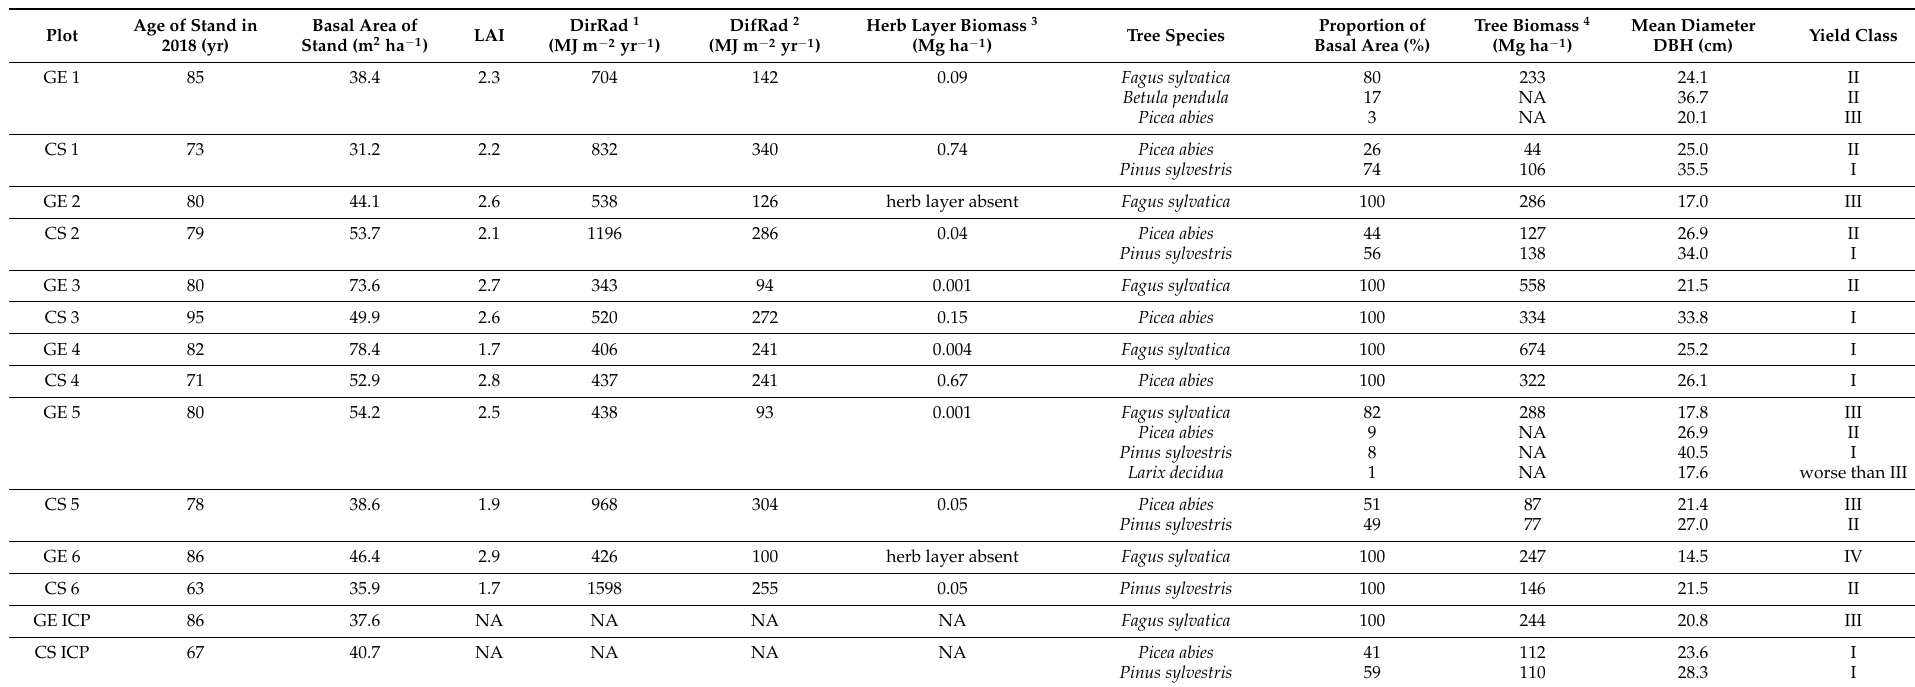
Table 2. Stand description. GE: Groups of European beech within stands of Norway spruce and Scots pine